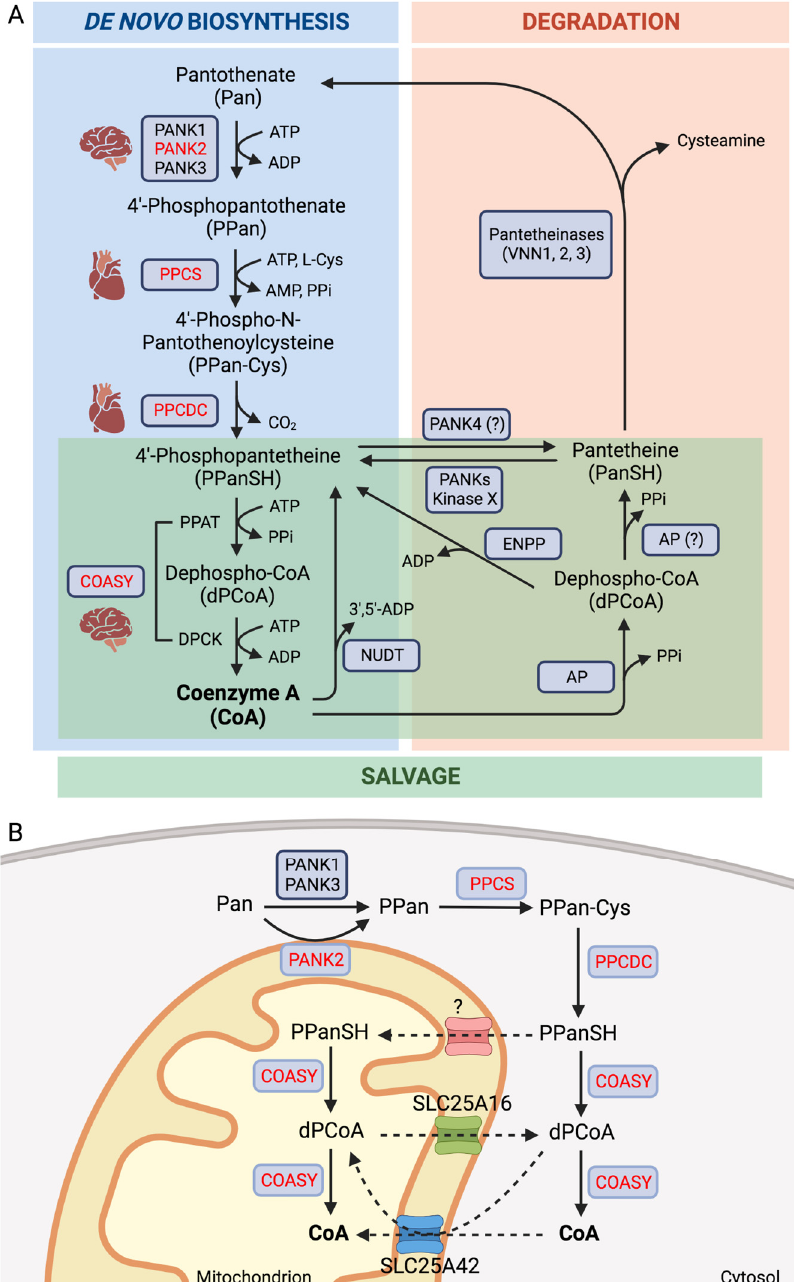
Figure 1. Coenzyme A homeostasis. ( A ) Schematic representation of CoA biosynthetic (blue), salvage (green), and degradation pathways. ( B ) Intracellular localization of CoA biosynthesis. Disease-associated enzymes are in red. Abbreviations: PANK, pantothenate kinase; PPCS, phosphopantothenoylcysteine synthetase; PPCDC, phosphopantothenoylcysteine decarboxylase; PPAT, phosphopantetheine adenyltransferase; DPCK, dephospho-CoA kinase; COASY, CoA synthase; NUDT, nucleoside diphosphate-linked moiety X-type motif; AP, alkaline phosphatase ENPP, ectonucleotide pyrophosphatase/phosphodiesterase.